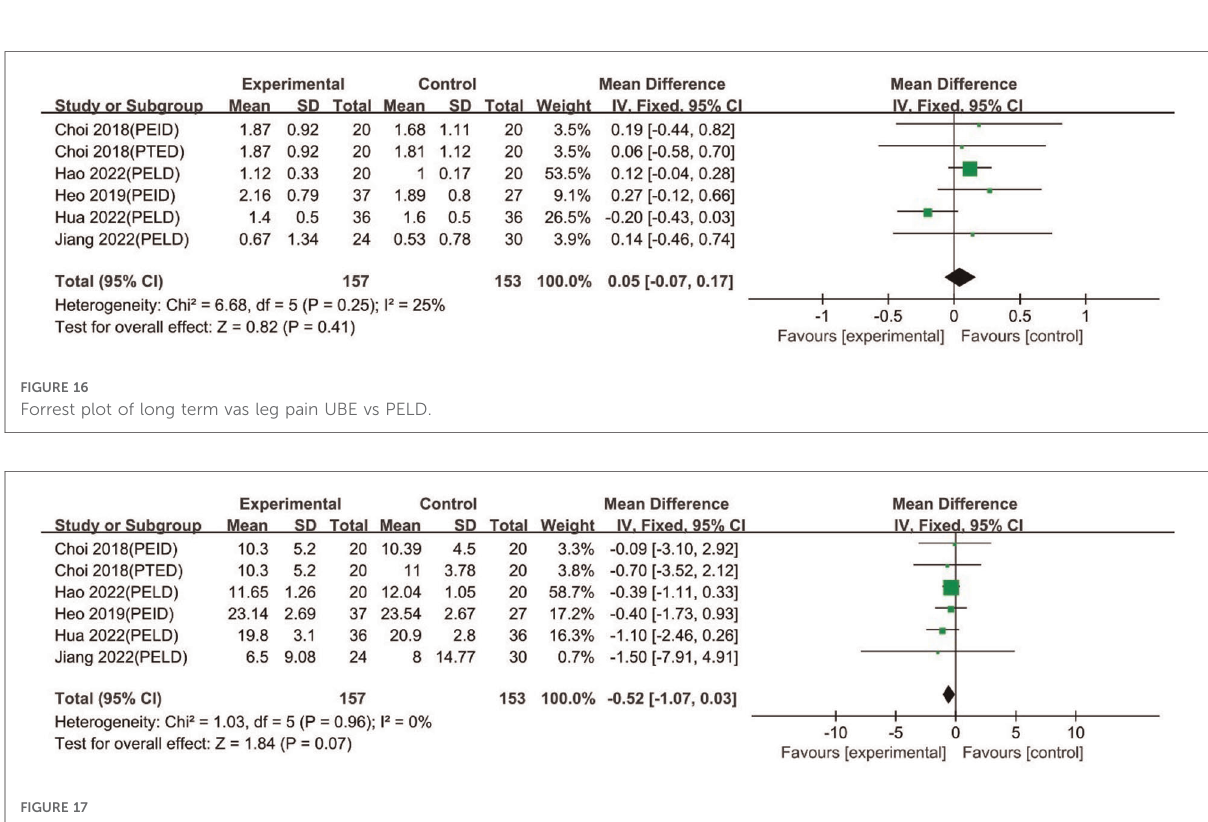
FIGURE 17 Forrest plot of ODI UBE vs